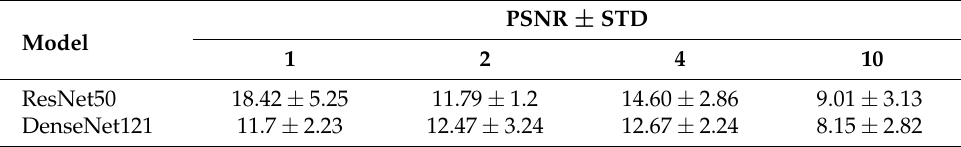
Table 5. Impact of batch size on attack success during late training. We report the mean PSNR and sample standard deviation (STD) over all images obtained from three attack trials per setting. Models were trained with frozen batch normalization layers (cf. Figure 2). Attack success deteriorated with a batch size of ten, but not significantly with smaller batch